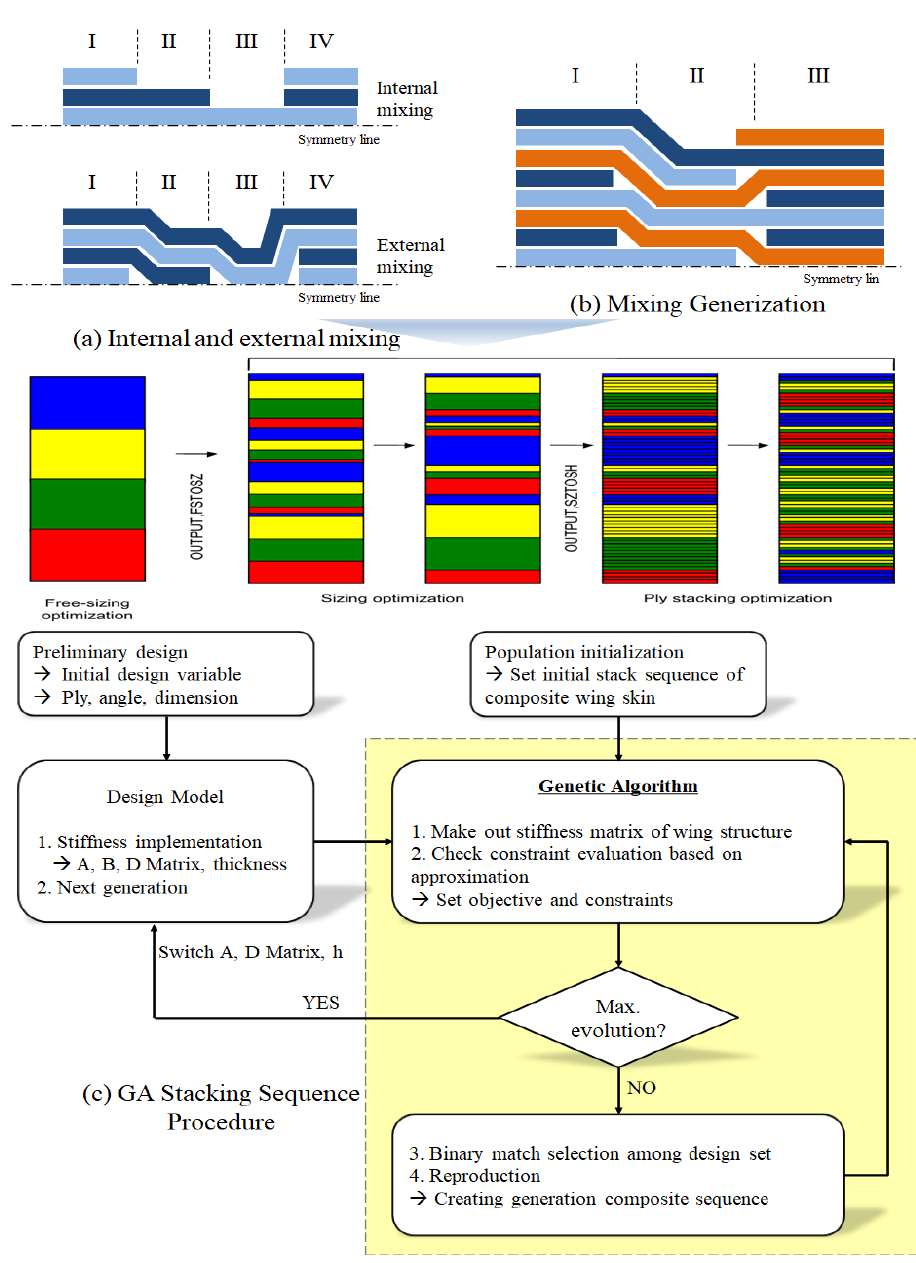
Figure 3. Schematic overview of a GA stacking sequence optimization in combination with approximations.